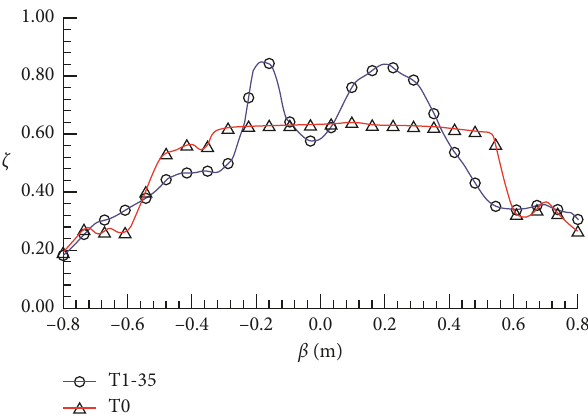
Figure 11: Variation of dissipation rate on L